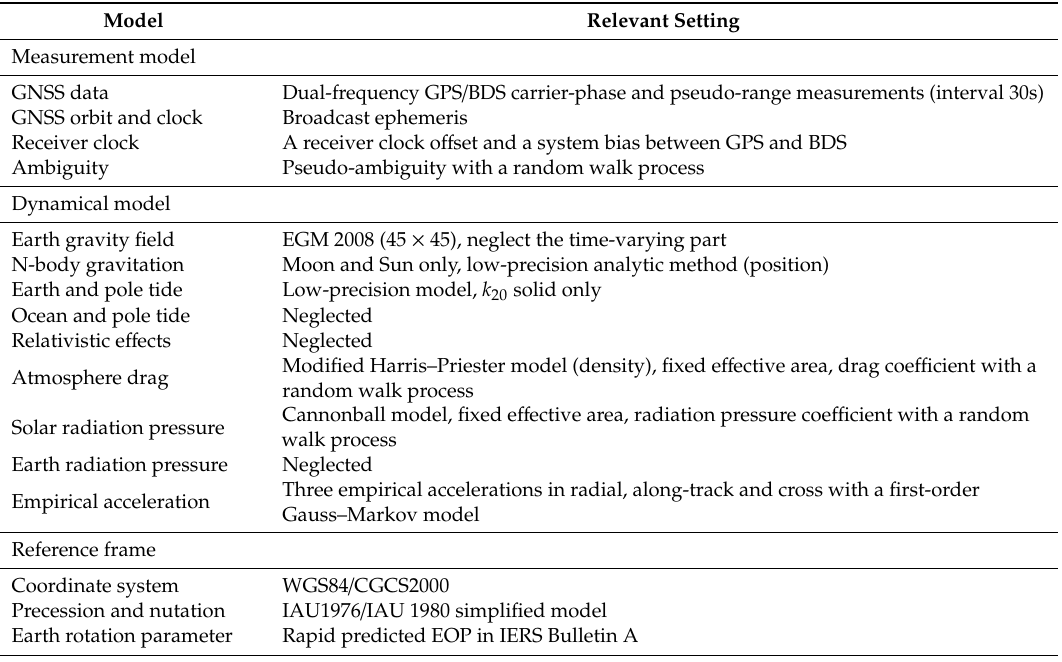
Table 3. Strategies of the onboard real-time orbit determination